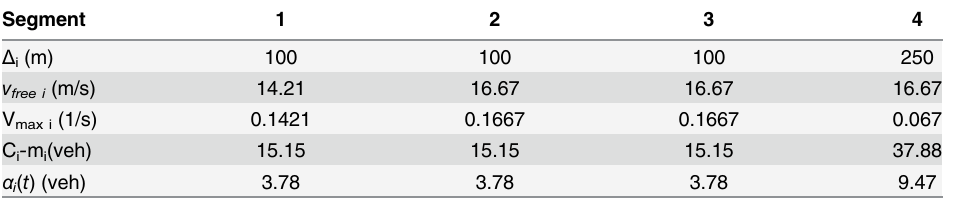
Table 5. Traffic parameters of VCPN (Jalan Langat).